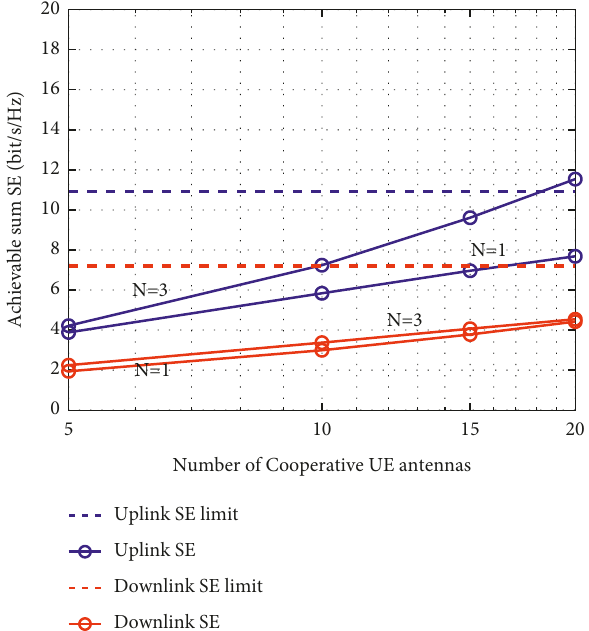
Figure 4: Total SE obtained as a function of N � {1,3}, K � 10 and M � 5 , ... ,